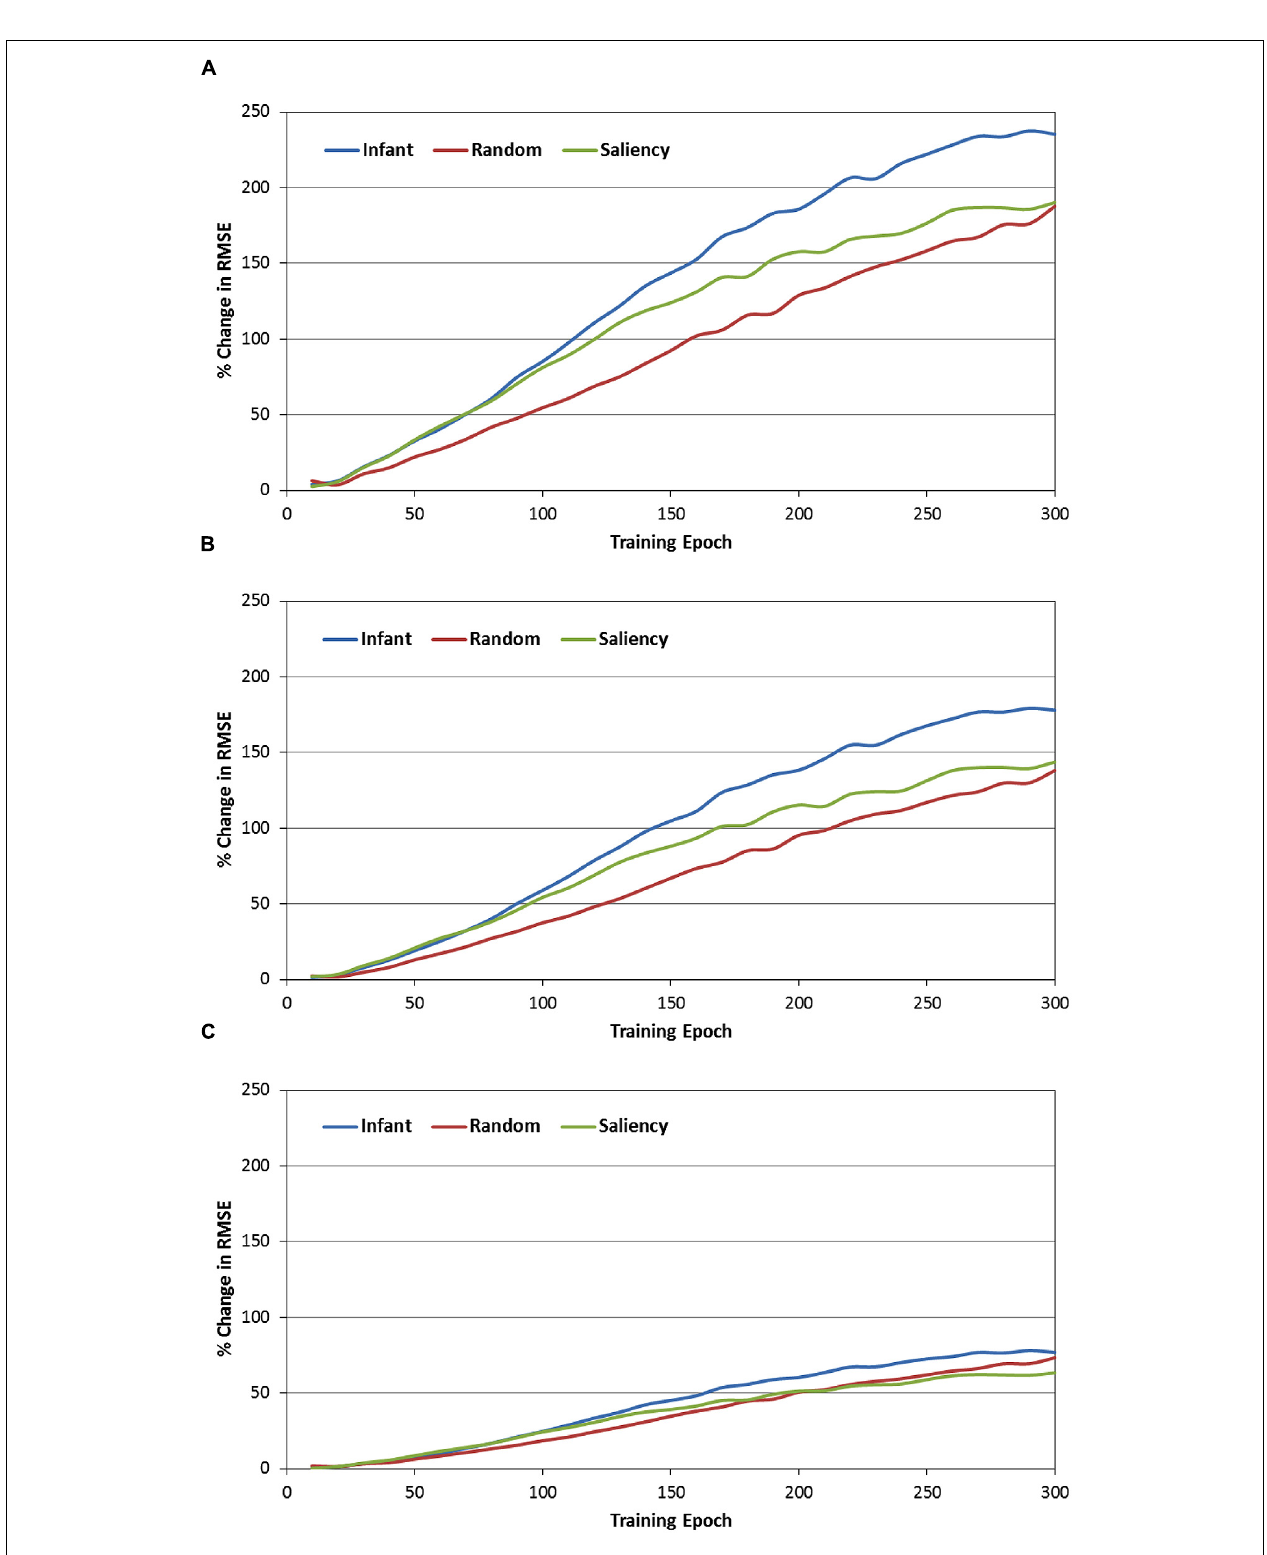
FIGURE 6 | Percent change in the MRSE during testing of the three observer groups, while resetting the recurrent layer units after every sample (A), every other sample (B), and every five samples (C).